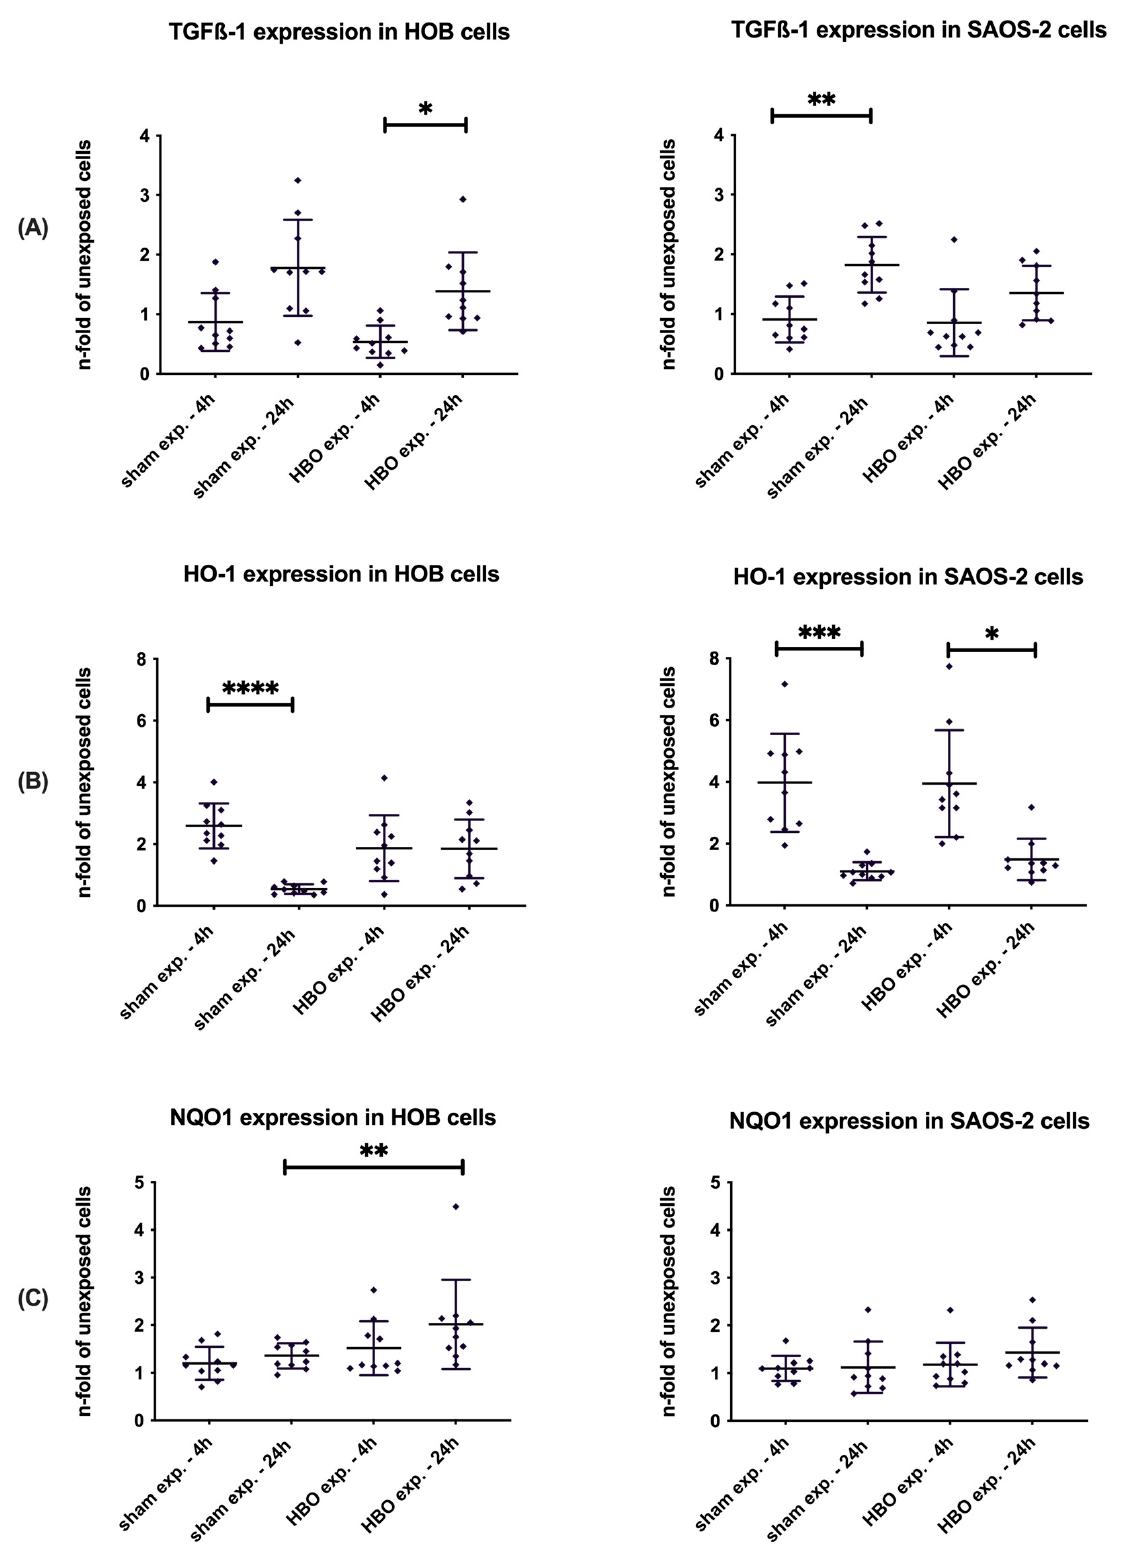
Figure 5. Gene expression of TGFß-1 ( A ), HO-1 ( B ), and NQO1 ( C ) in HOB and SAOS-2 cells after exposure to hyperbaric oxygen (HBO exposure) and ambient air (sham exposure) normalized to baseline. Data are presented as mean ± SD; p -values: * p < 0.05, ** p < 0.01, *** p < 0.001, **** p < 0.0001.